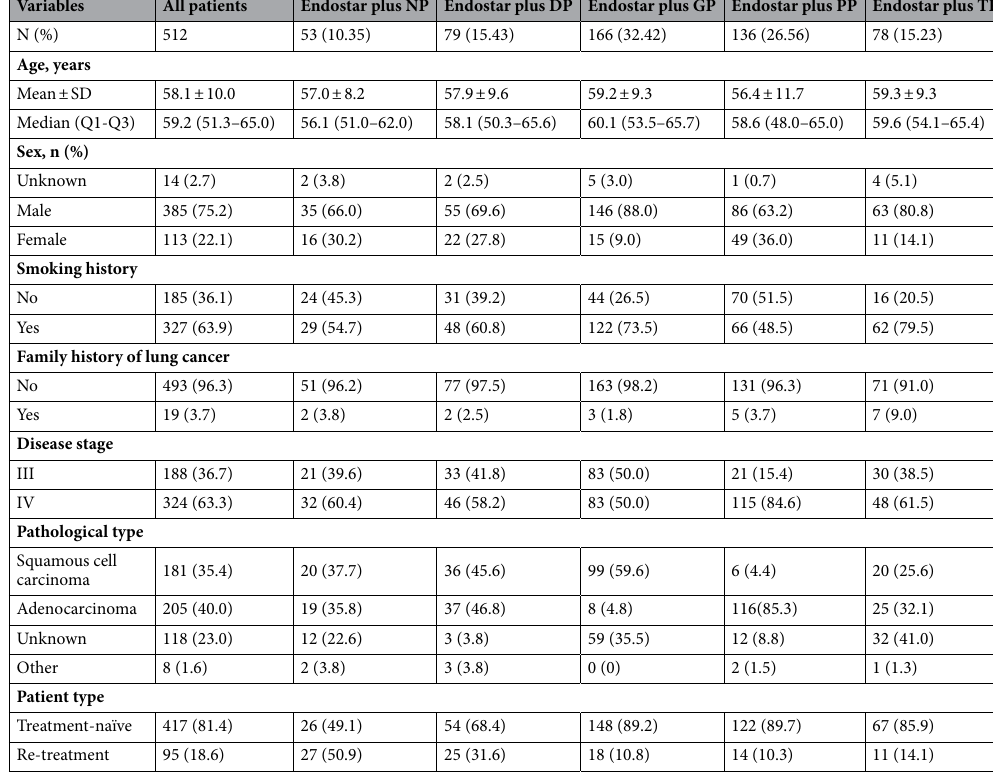
Table 1. Real-world treatment pattern and baseline characteristics of Endostar plus different chemotherapy in all